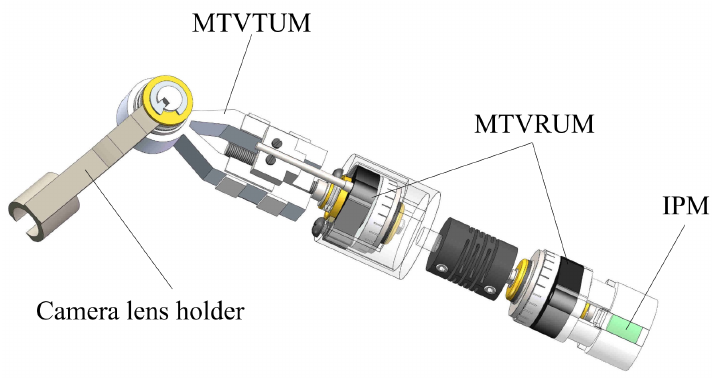
Figure 10. Structure of the